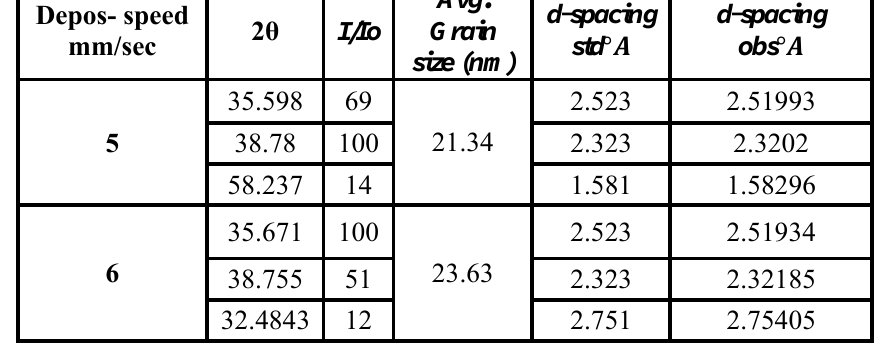
Table 1: Lattic parameter of CuO layer compared with standared card. Depos- speed